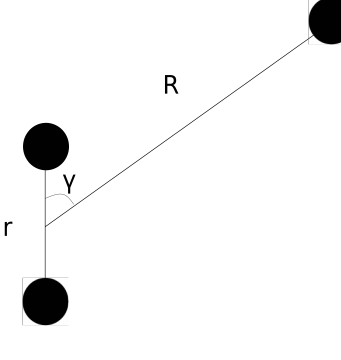
Figure 1. Jacobi coordinates in the body-fixed frame used in this